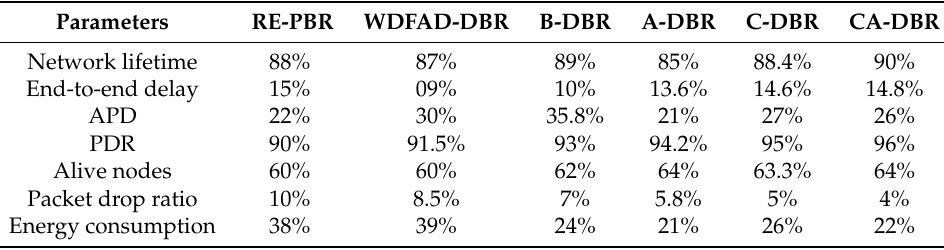
Table 3. Summarized simulation